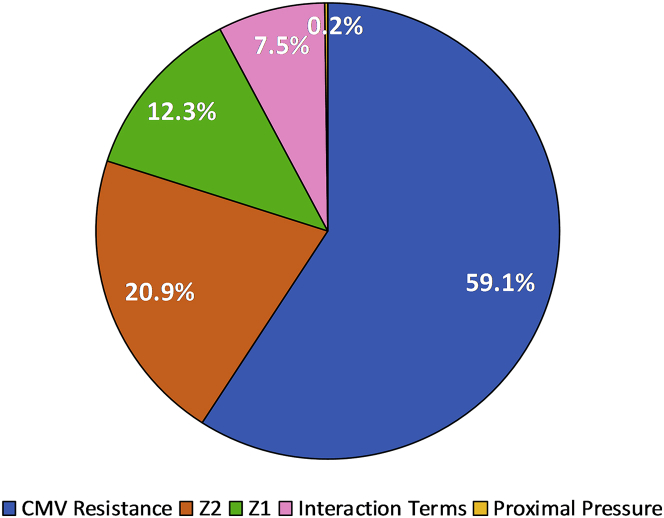
Pie Chart Demonstrates Relative Effect of Each Individual Model Input Parameter on Model Output (vFFR) VarianceSee Supplemental Appendix D.